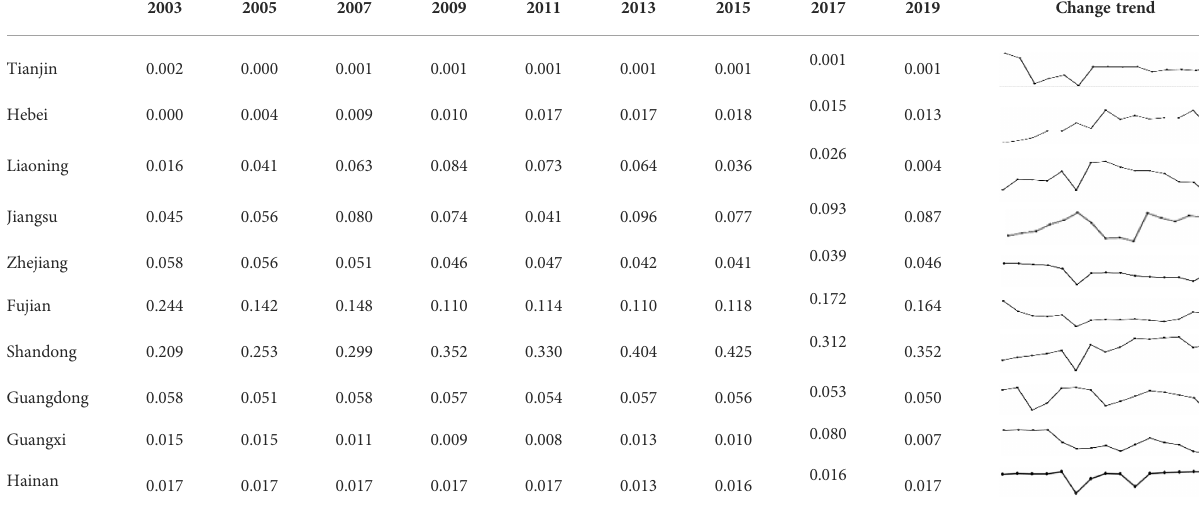
TABLE 2 Rationalization index of production structure of China ’ s marine fi shery culture.